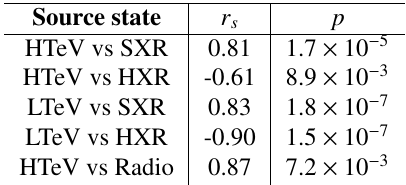
Figure 3. Di ff erential spectrum of the γ -ray emission from Cyg X-3 and image of Cyg X-3 at energies > 0 . 8 TeV during the flux increase in 1995. Table 1. Test of the correlation between the data obtained in the SHALON observations of Cyg X-3 and at low